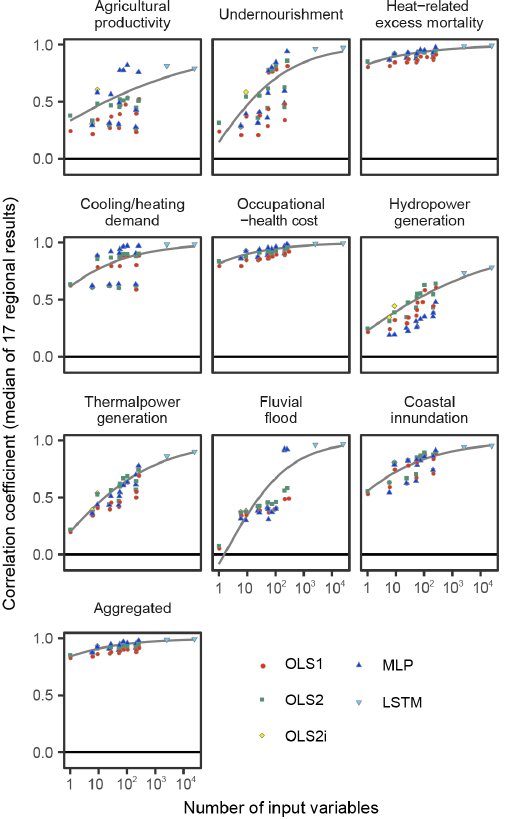
Figure 5. Performance of emulations in comparison 4. Correlation coefficients between simulation results and emulation results are shown. MLP(1) denotes that MLPs are used as the emulators and that only climatic and socioeconomic variables for the target year are used. LSTM(10) and LSTM(95) denote that LSTMs are used as the emulators and that the climatic and socioeconomic variables for 10 and 95 years are used, respectively.